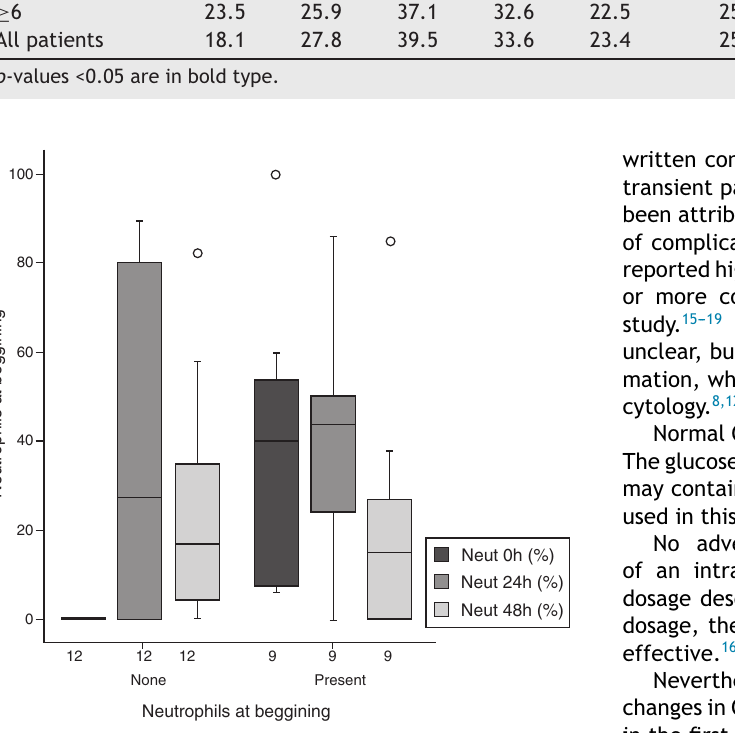
Evolution of percentage of neutrophils at 0 h, 24 h, and 48 h in relation to tests that showed neutrophils at 0 h versus those who did not present any